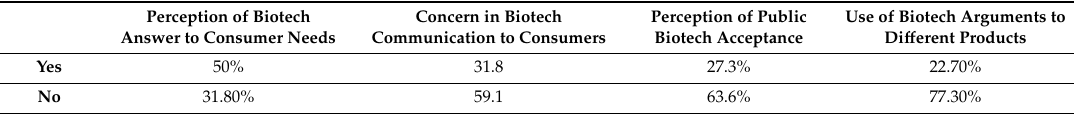
Table 1. Perception of consumer’s biotechnology acceptance.